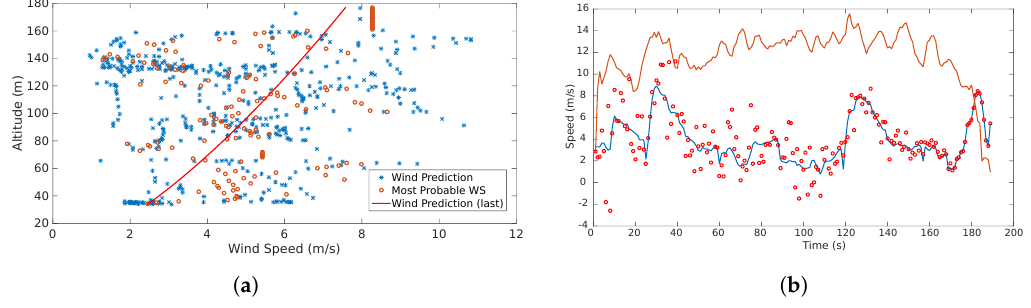
Figure 15. ( a ) shows the estimation, most probable wind speeds and last shear wind prediction generated throughout the flight; ( b ) indicates the wind speed estimation (blue line), wind speed prediction (red dots) and airspeed (orange